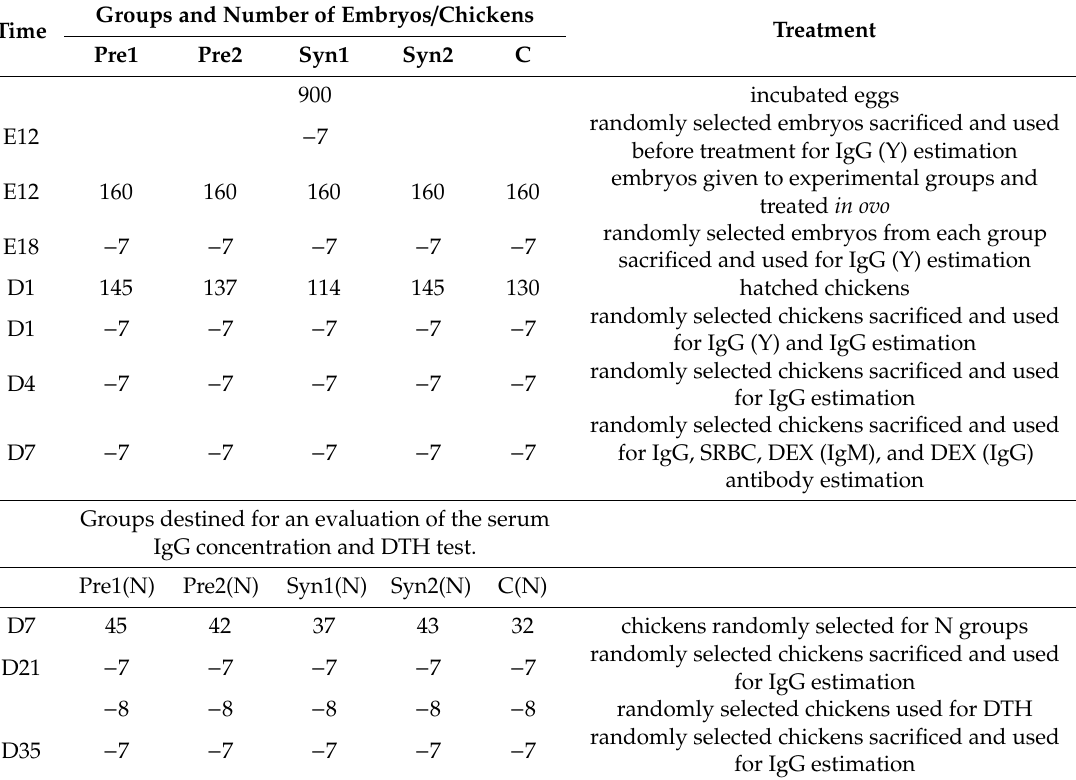
Table 1. Number of embryos and chickens used in the experiment.